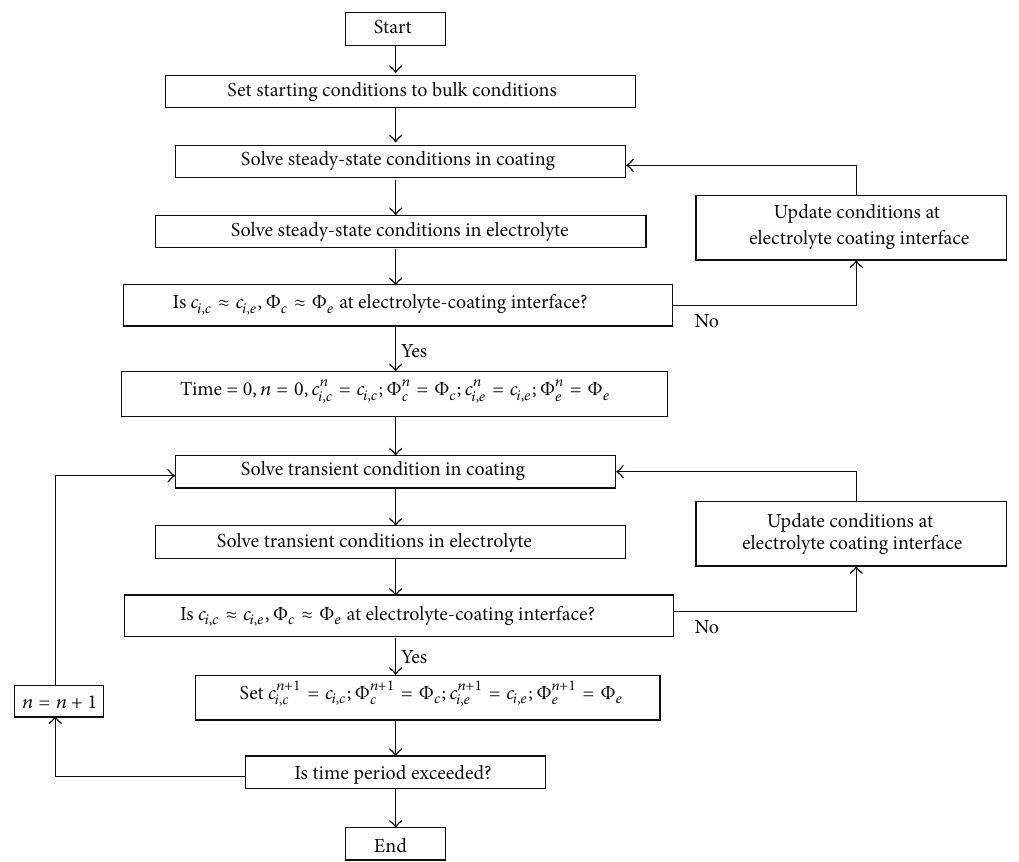
Figure3:Blockdiagramoutliningthesolutionmethodusedforcalculatingthesteady-stateandtransientconditionsintheelectrolyte-coating